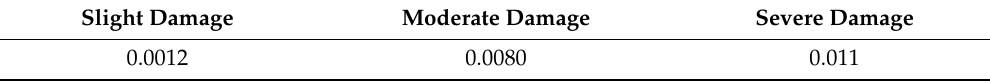
Table 5. Assumed drift x 0 thresolds for performance levels, extracted from